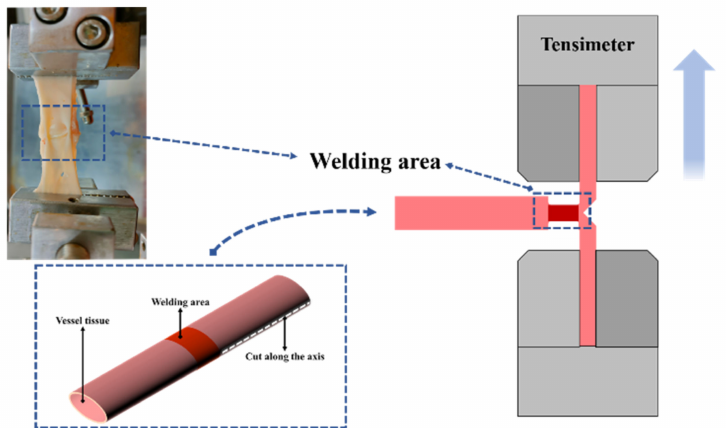
Figure 3. Simplified schematic diagram of T-peel test. Cut one end of the vessel tissue along the long axis of the vessel to the edge of the welding area (as shown in the lower left corner) so that the vessel tissue at this end changes from a complete wall structure to two lobes of vessel tissue attached to the welding area. The two cleaved vessel tissues are loaded into the upper and lower jaws of